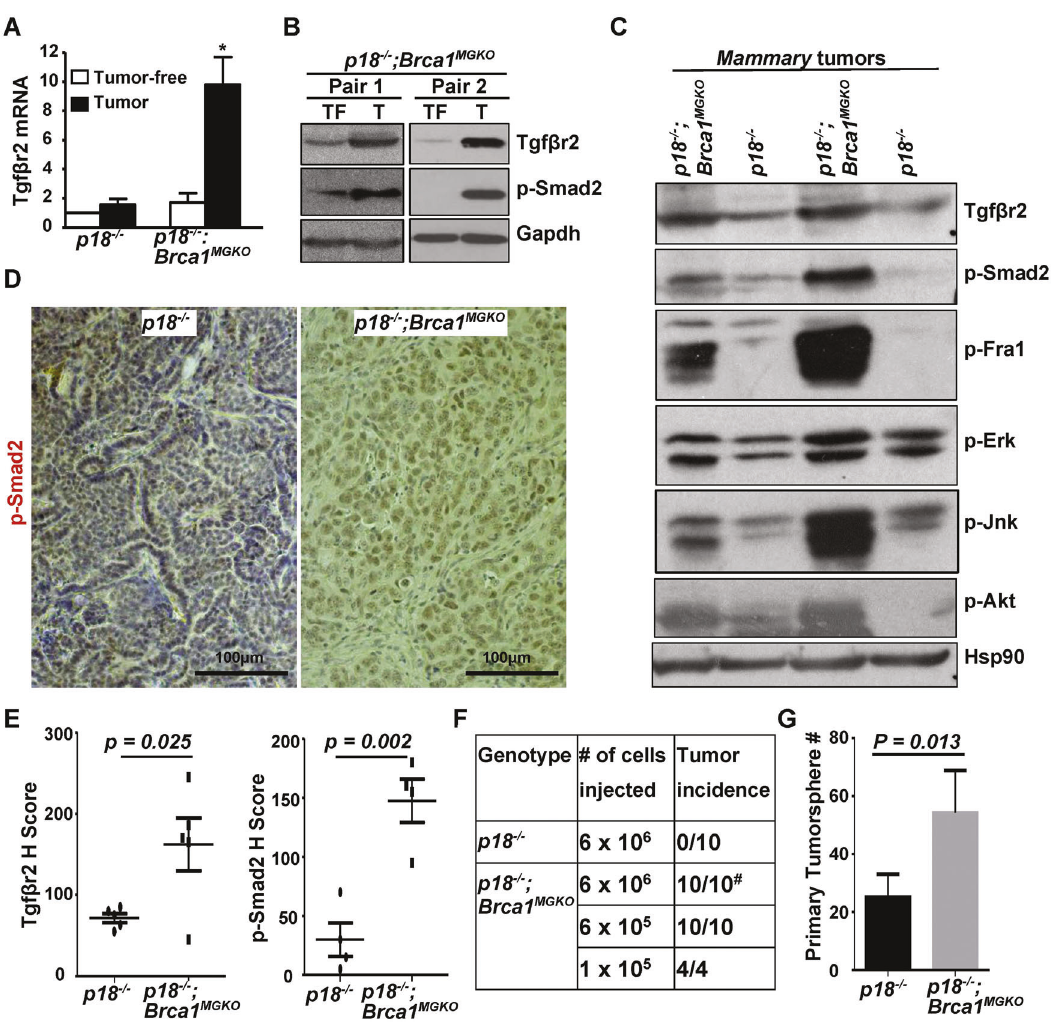
Fig. 2 Deletion of Brca1 in p18 − / − epithelia activates Tgf β r2 signaling pathways and promotes tumor-initiating potential. A, B Tumors (T) from p18 − / − and p18 − / − ; Brca1 MGKO mice were analyzed by qRT-PCR (A) and western blot ( B ). Tumor-free mammary glands (TF) from the same mouse were used as controls. Data in ( A ) represent the mean ± SD of three tumors in each group. The asterisk (*) denotes a signi fi cance from tumors and tumor-free tissues of the same genotype by a two-tailed, unpaired T test. C Four representative tumors from p18 − / − and p18 − / − ; Brca1 MGKO mice were analyzed by western blot. D Representative immunostaining of mammary tumors from a p18 − / − and p18 − / − ; Brca1 MGKO mice. E p18 − / − and p18 − / − ; Brca1 MGKO mammary tumors were analyzed by IHC, and H-scores for Tgf β r2 and p-Smad2 were calculated. The results represent the mean ± SD of fi ve individual tumors per group for Tgf β r2 and four individual tumors per group for p-Smad2. F p18 − / − and p18 − / − ; Brca1 MGKO mammary tumor cells were transplanted into MFPs of NSG mice. Four weeks later, recipient mice with tumors generated (>0.5 cm 3 in size) were analyzed. # fi ve tumor-bearing mice displayed lung metastasis by H.E. analysis. G 3 ×10 4 p18 − / − and p18 − / − ; Brca1 MGKO mammary tumor cells were cultured to generate primary tumorspheres in 10 days. The number of spheres large than 50 μ m was quanti fi ed from triplicate experiments. The results represent the mean ± SD of three individual tumors per group. Statistical signi fi cance in ( E ) and ( G ) was determined by a two-tailed, unpaired T test.